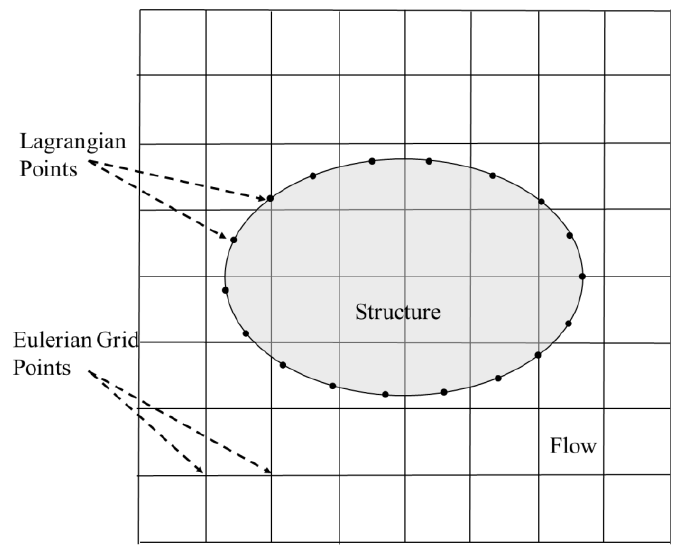
Figure 1. Mesh schematic for IBM method.